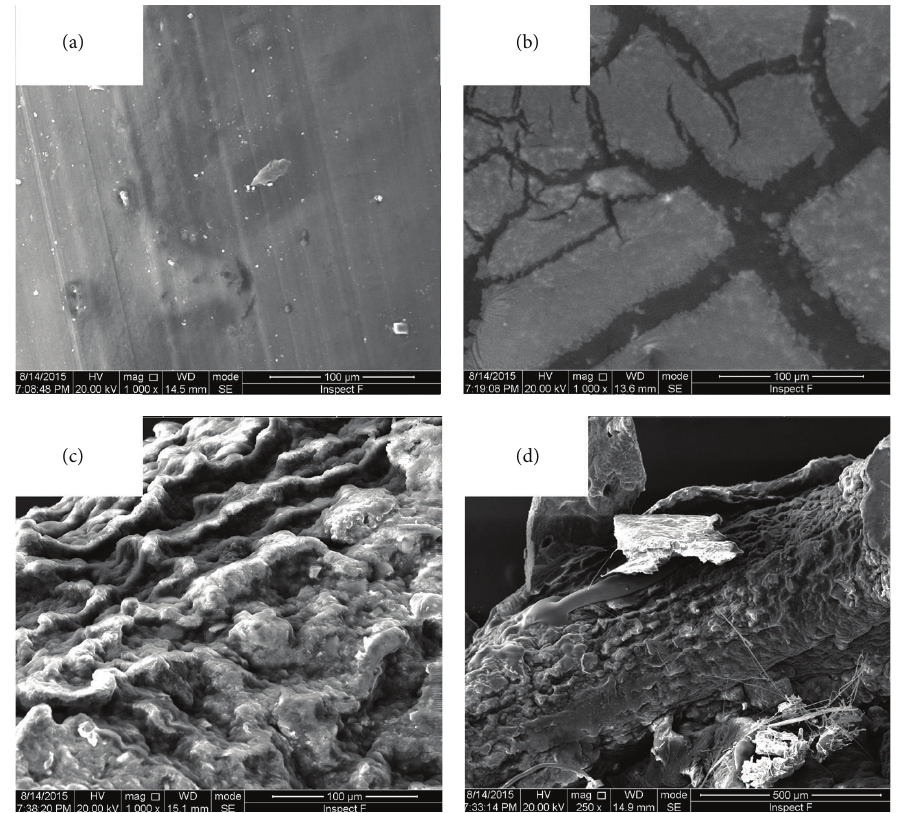
Figure 8: The morphology change of PLGC (20mol% CL) with in vitro hydrolytic degradation observed under SEM; (a)–(c) surface and (d) cross section; (a) 0 weeks; (b) 2 weeks; (c) and (d) 6 weeks.